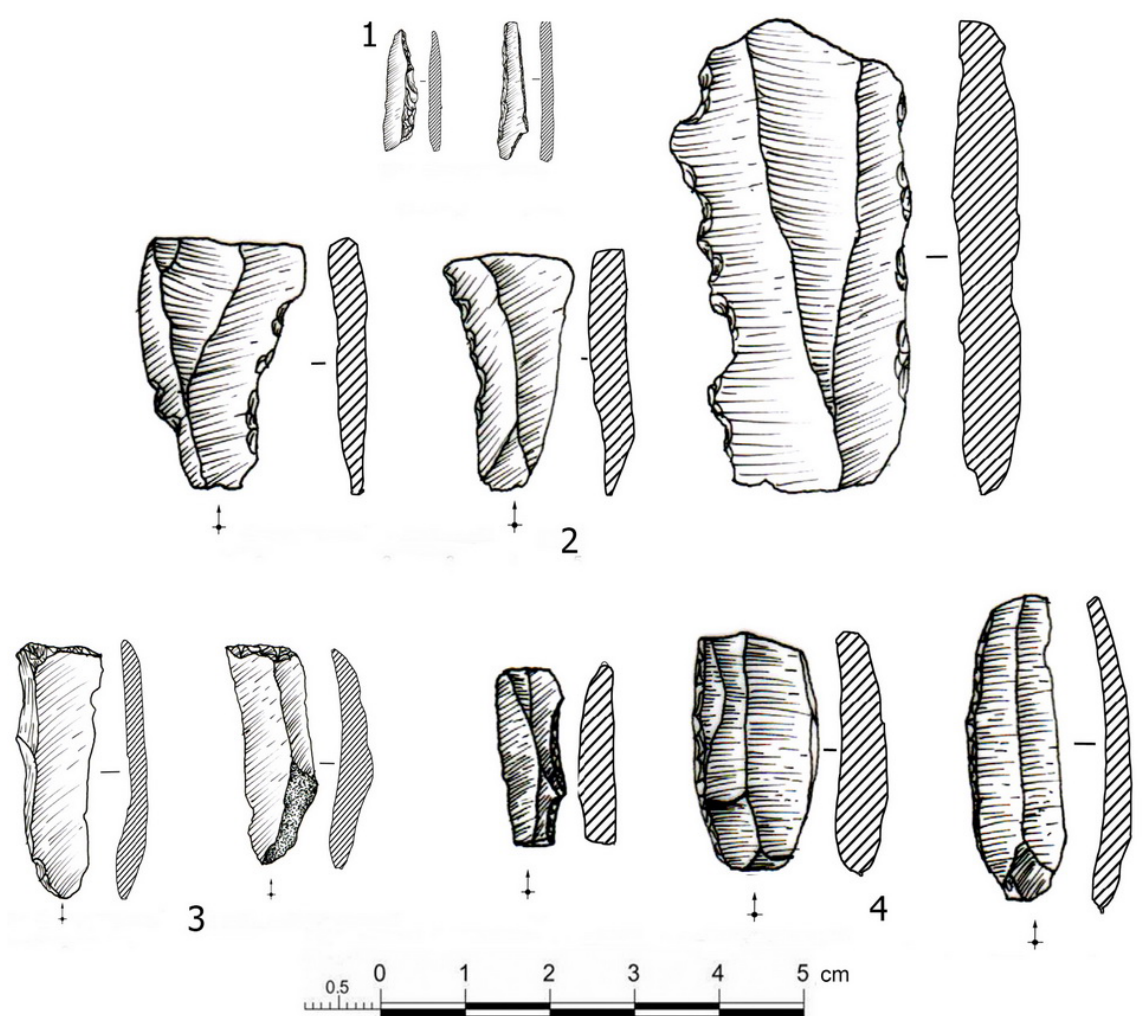
Figure 16. Collection of backed points, denticulates, truncations and backed blades located at Tajo de